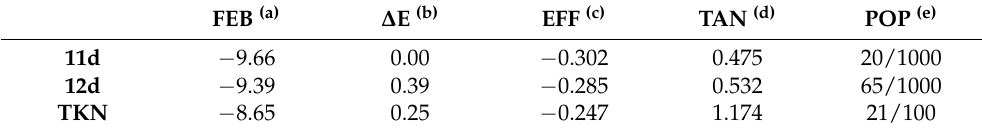
Table 6. Docking scores for compound 11d and 12d to